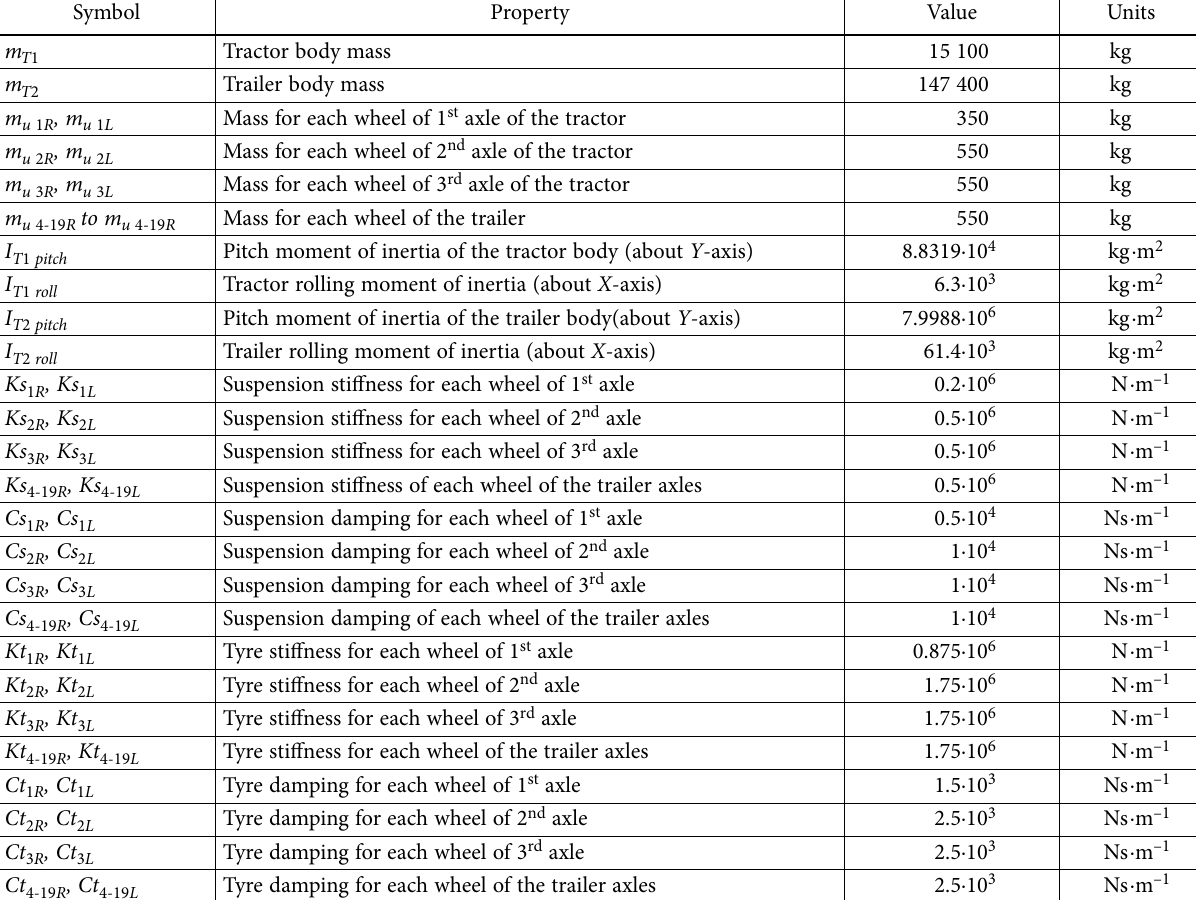
Tyre stiffness for each wheel of 1 st axle 0.875·10 6 Tyre stiffness for each wheel of 2 nd axle 1.75·10 6 Tyre stiffness for each wheel of 3 rd axle 1.75·10 6 Kt 4-19 R , Kt 4-19 L Tyre stiffness for each wheel of the trailer axles 1.75·10 6 Tyre damping for each wheel of 1 st axle Tyre damping for each wheel of 2 nd axle Tyre damping for each wheel of 3 rd axle Tyre damping for each wheel of the trailer